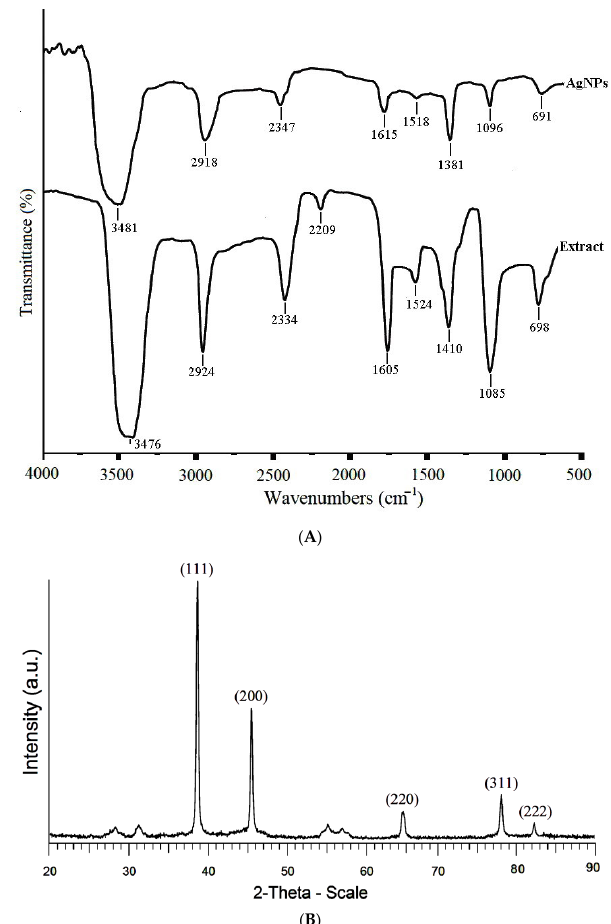
Figure 2. ( A ) The FTIR spectrum of the A. tribuloides root extract and the greenly synthesized AgNPs. ( B ) The XRD pattern of the AgNPs produced by using the A. tribuloides root extract.